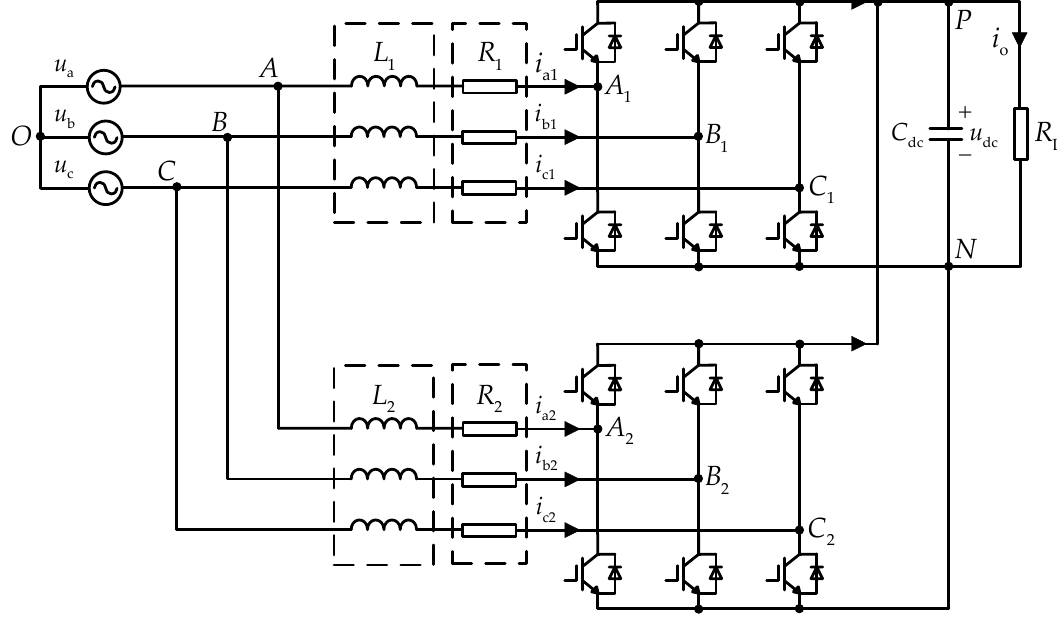
Figure 4. Topology of two paralleled three-phase voltage-source PWM converters.